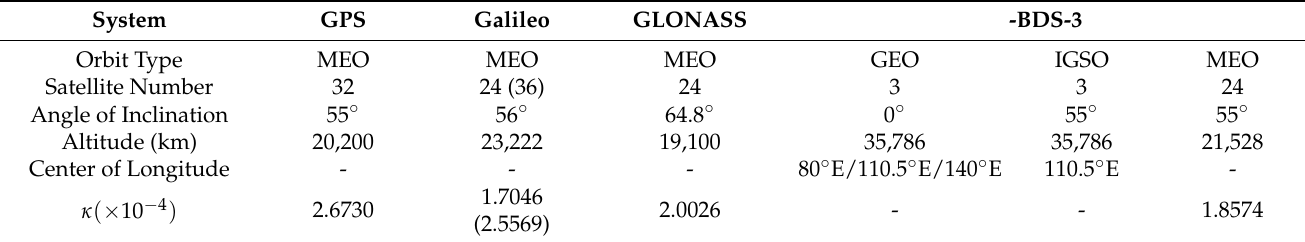
Table 1. Constellation parameters of four-GNSS and κ of the observation probabilities of MEO satellites. System